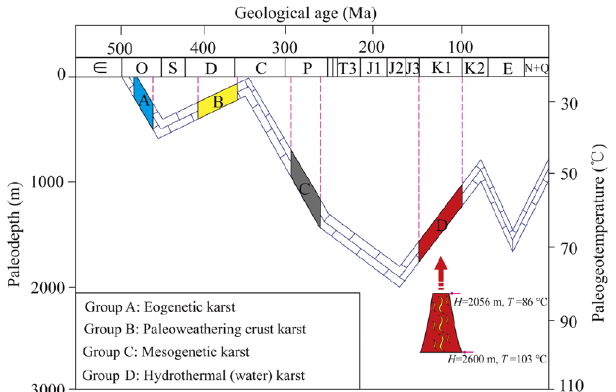
Figure 11. Formation environments of the Ordovician carbonate paleokarst in the Southern North China Basin.